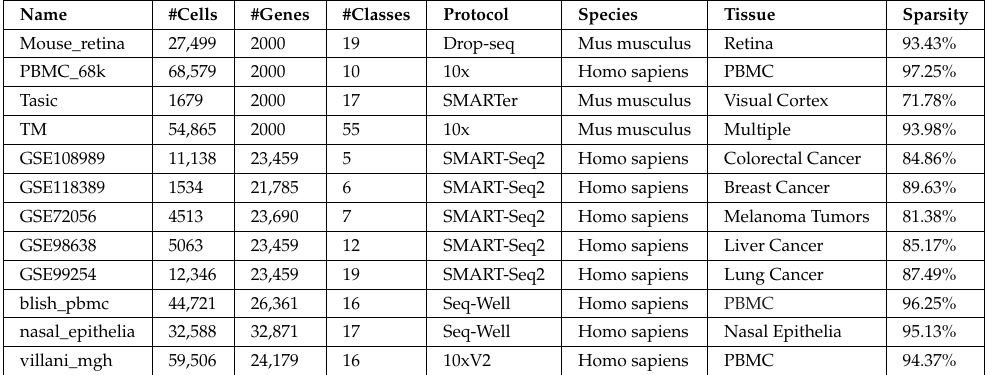
Table 1. Real datasets used for comparing scAGN’s performance with baseline